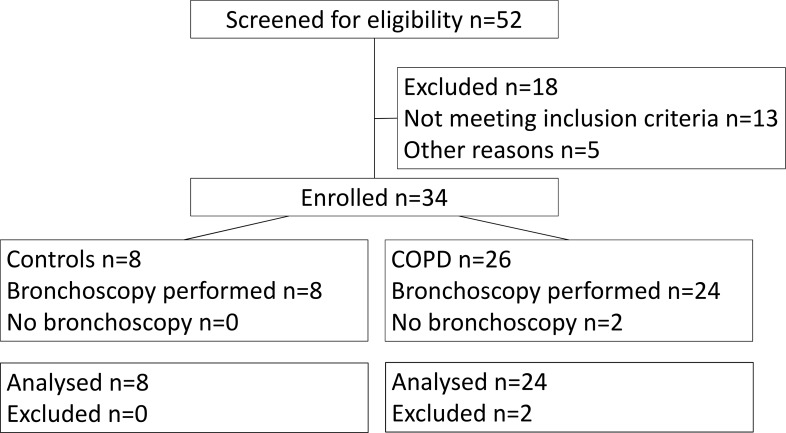
Volunteer recruitment CONSORT diagram.Subjects who did not undergo bronchoscopy were excluded based on HRCT finding of other lung pathologies.